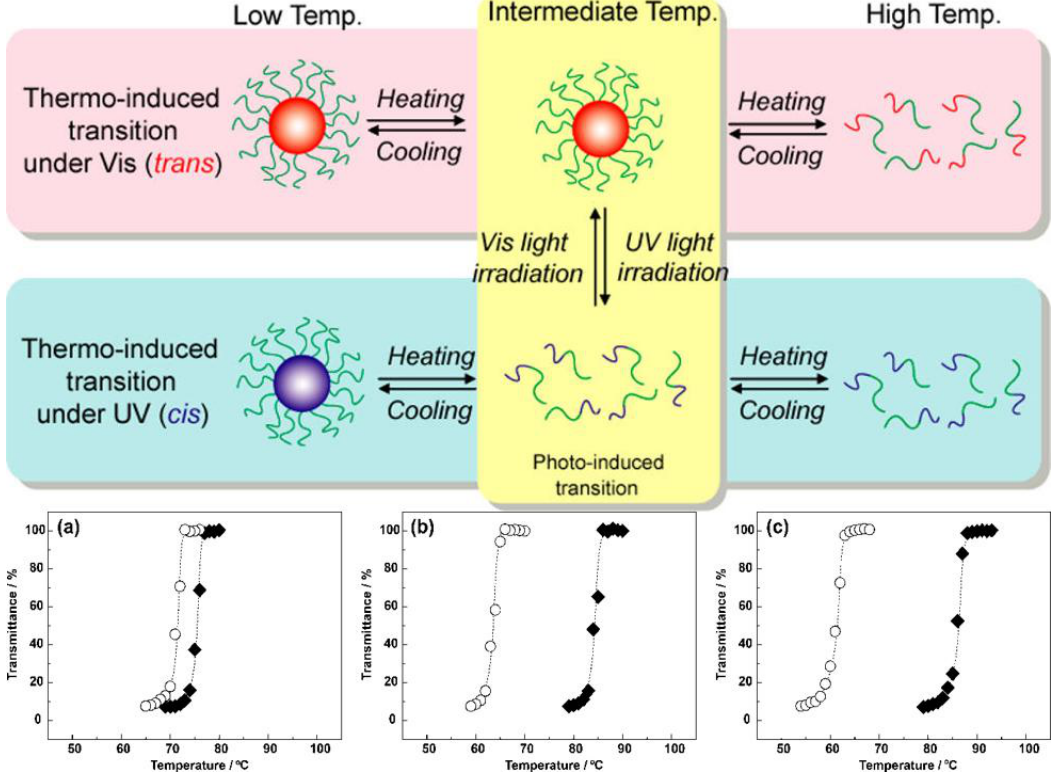
Figure 3. The top row highlights the characteristics of dual stimuli-responsive block copolymer micelles; below, turbidity measurements for: ( a ) p(AzoMA 1.9 - r -NIPAAm); ( b ) p(AzoMA 5.4 - r -NIPAAm); and ( c ) P(AzoMA 8.6 - r -NIPAAm) in [C 4 mim]PF 6 solution are shown upon irradiation with UV light (366 nm, open circles) or in the dark (closed diamonds); the subscript denotes the respective content (mol %) of AzoMA in the random copolymers. Adapted with permission from Ref. [51]. Copyright 2012 American Chemical Society.